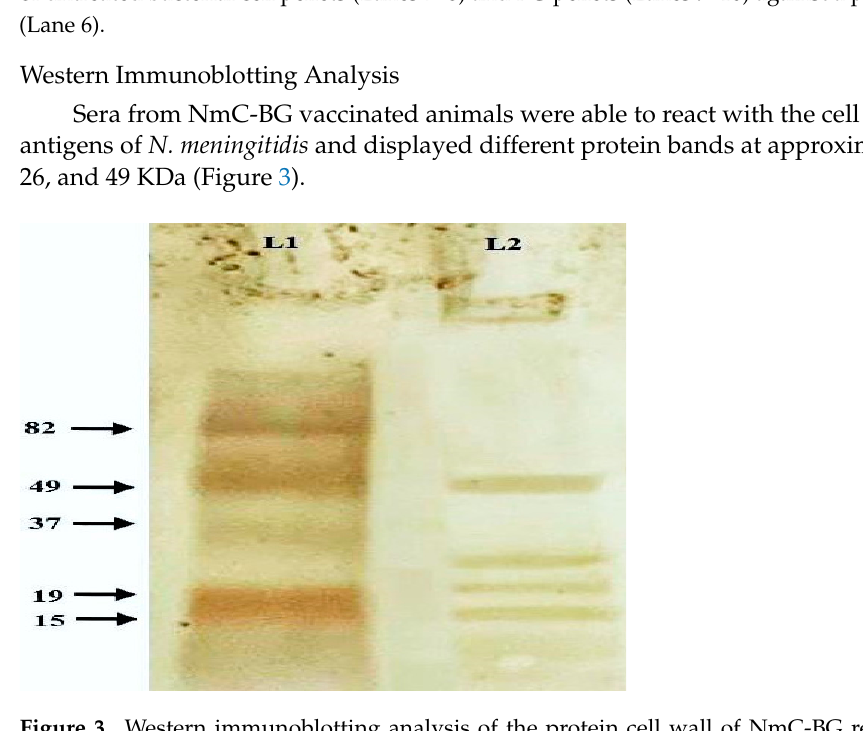
Figure 3. Western immunoblotting analysis of the protein cell wall of NmC-BG reacted animal BG-derived antibodies. The nitrocellulose membrane image showing the antigenic protein bands of BG pellets (Lane 2) against a pre-stained protein marker (Lane